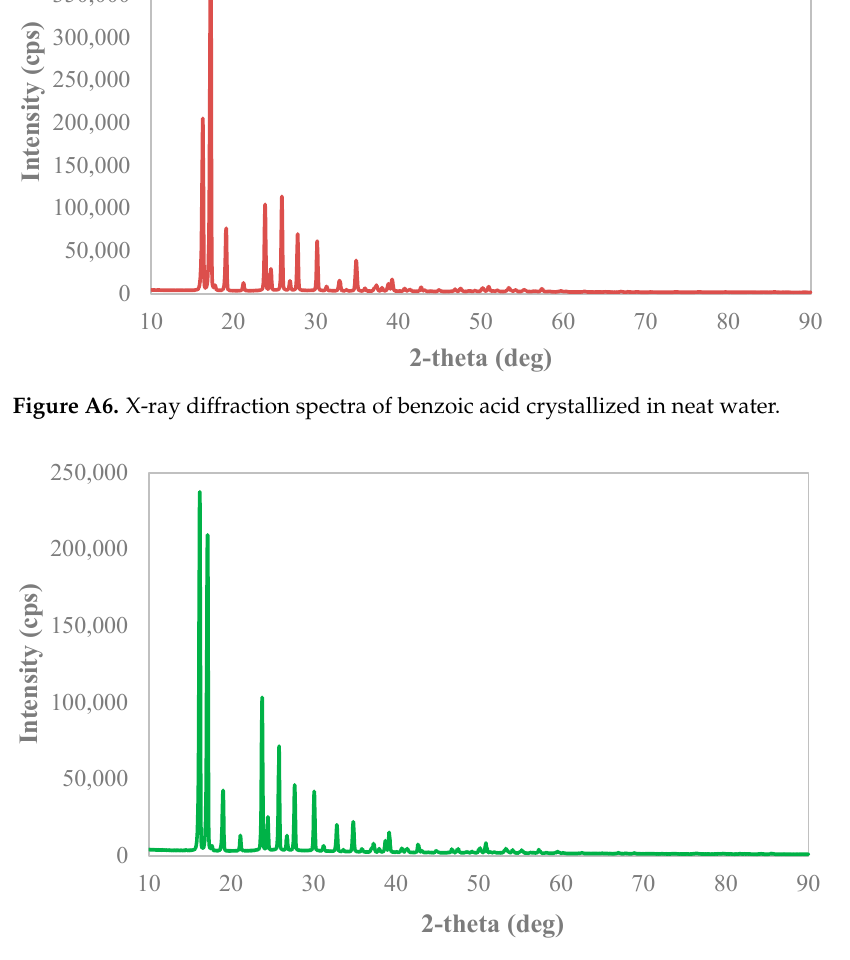
2-theta (deg) Figure A7. X-ray diffraction spectra of benzoic acid crystallized in {ethanol (1) + water (2)} ( x 1 = 0.50) mixture.